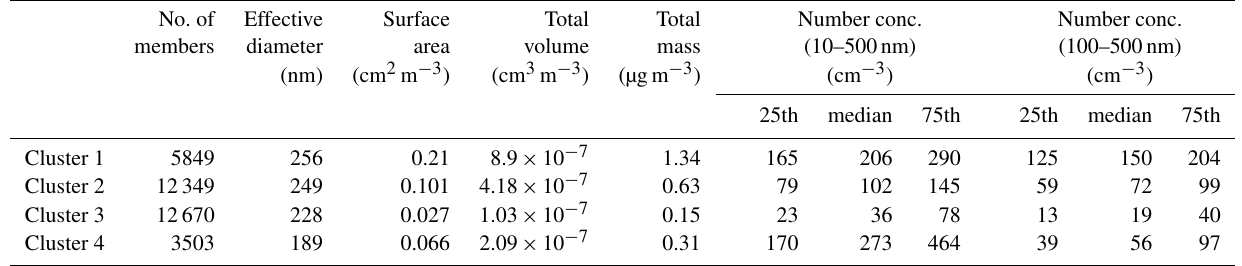
Table 1. Quantitative information about the cluster centroids and members, which was the result of the k -means cluster analysis. The effective diameter, surface area, total volume and total mass are the centroid values, while the percentiles of the number concentrations are derived from all the cluster